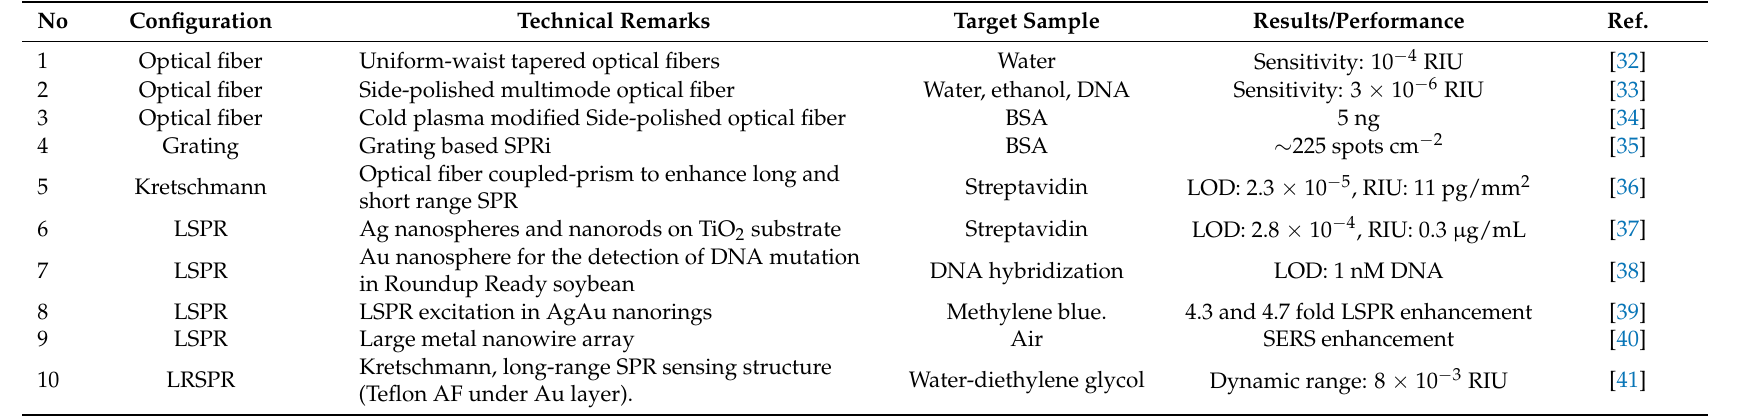
Table 2. The summary of SPR sensor development utilizing halogen lamp